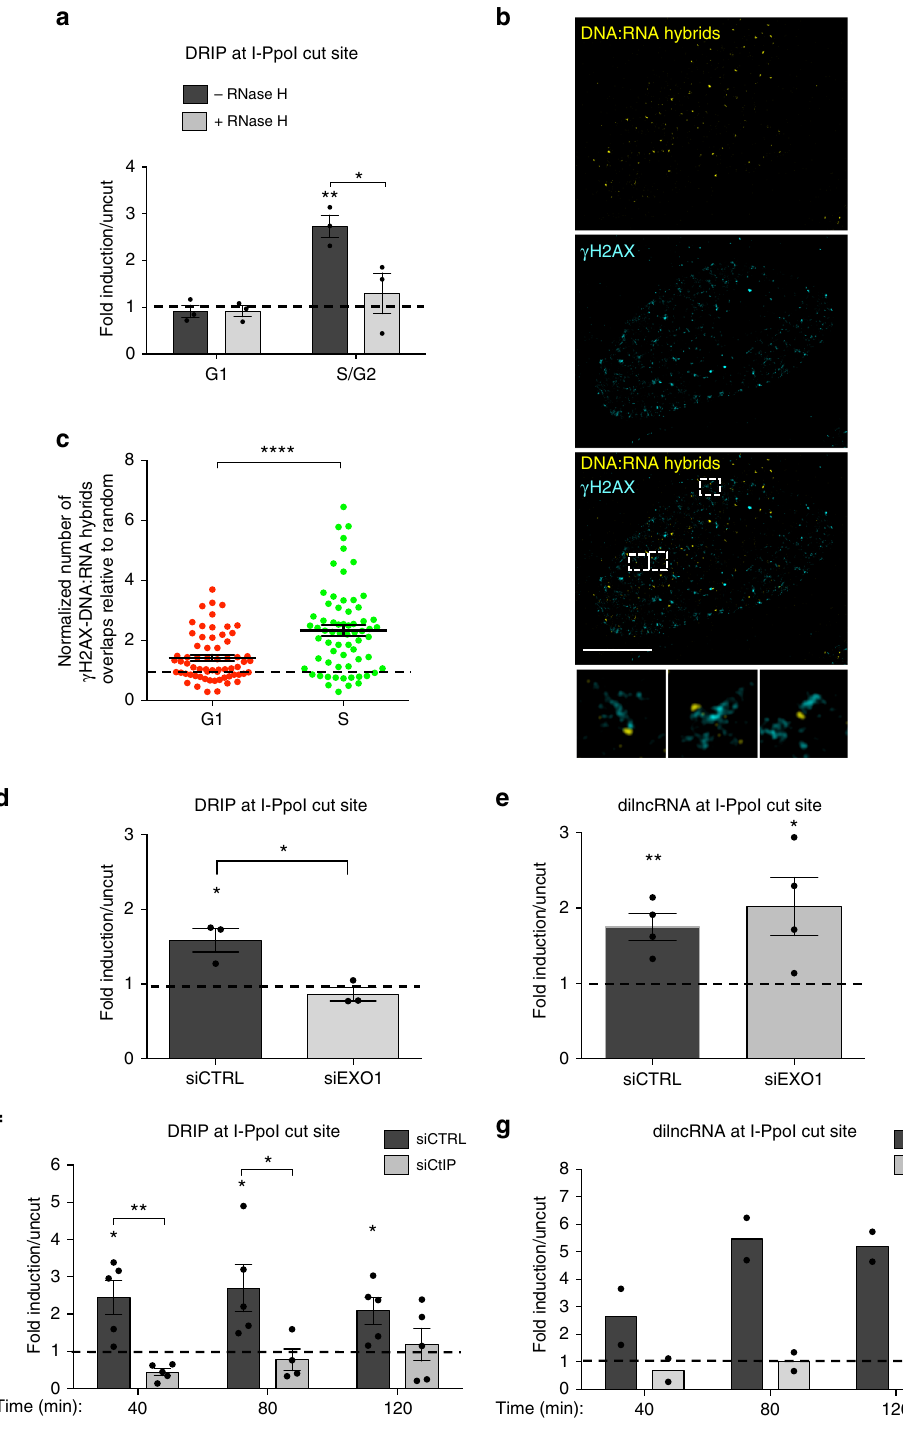
complementary sequences (Inactive) did not inhibit HR and all the ASOs left cell-cycle unaltered (Supplementary Fig. 4b). In this same cell system, genomic PCR can also be used to study SSA, a RAD52- dependent but RAD51-independent mechanism that shares with HR the initial DNA-end resection step. We observed that ASOs do not inhibit SSA (Fig. 3g), further indicating that dilncRNA inactivation impacts the HR process downstream of DNA-end resection. The impact of ASO-mediated dilncRNA inactivation on HR was further assessed using a different reporter system, the traf fi c